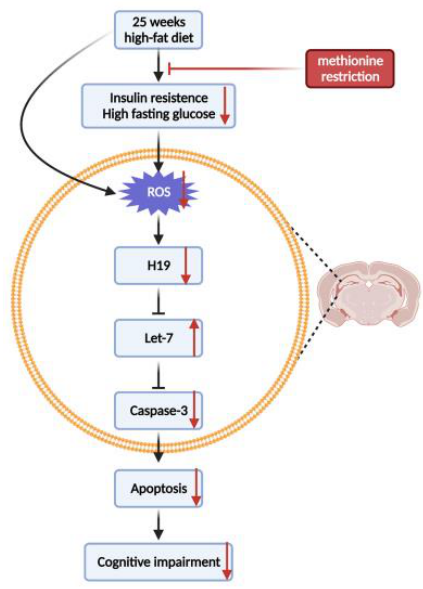
Figure 9. The mechanism of MR on improving cognitive ability by reducing hippocampal neuronal apoptosis in middle-aged insulin-resistant mice.